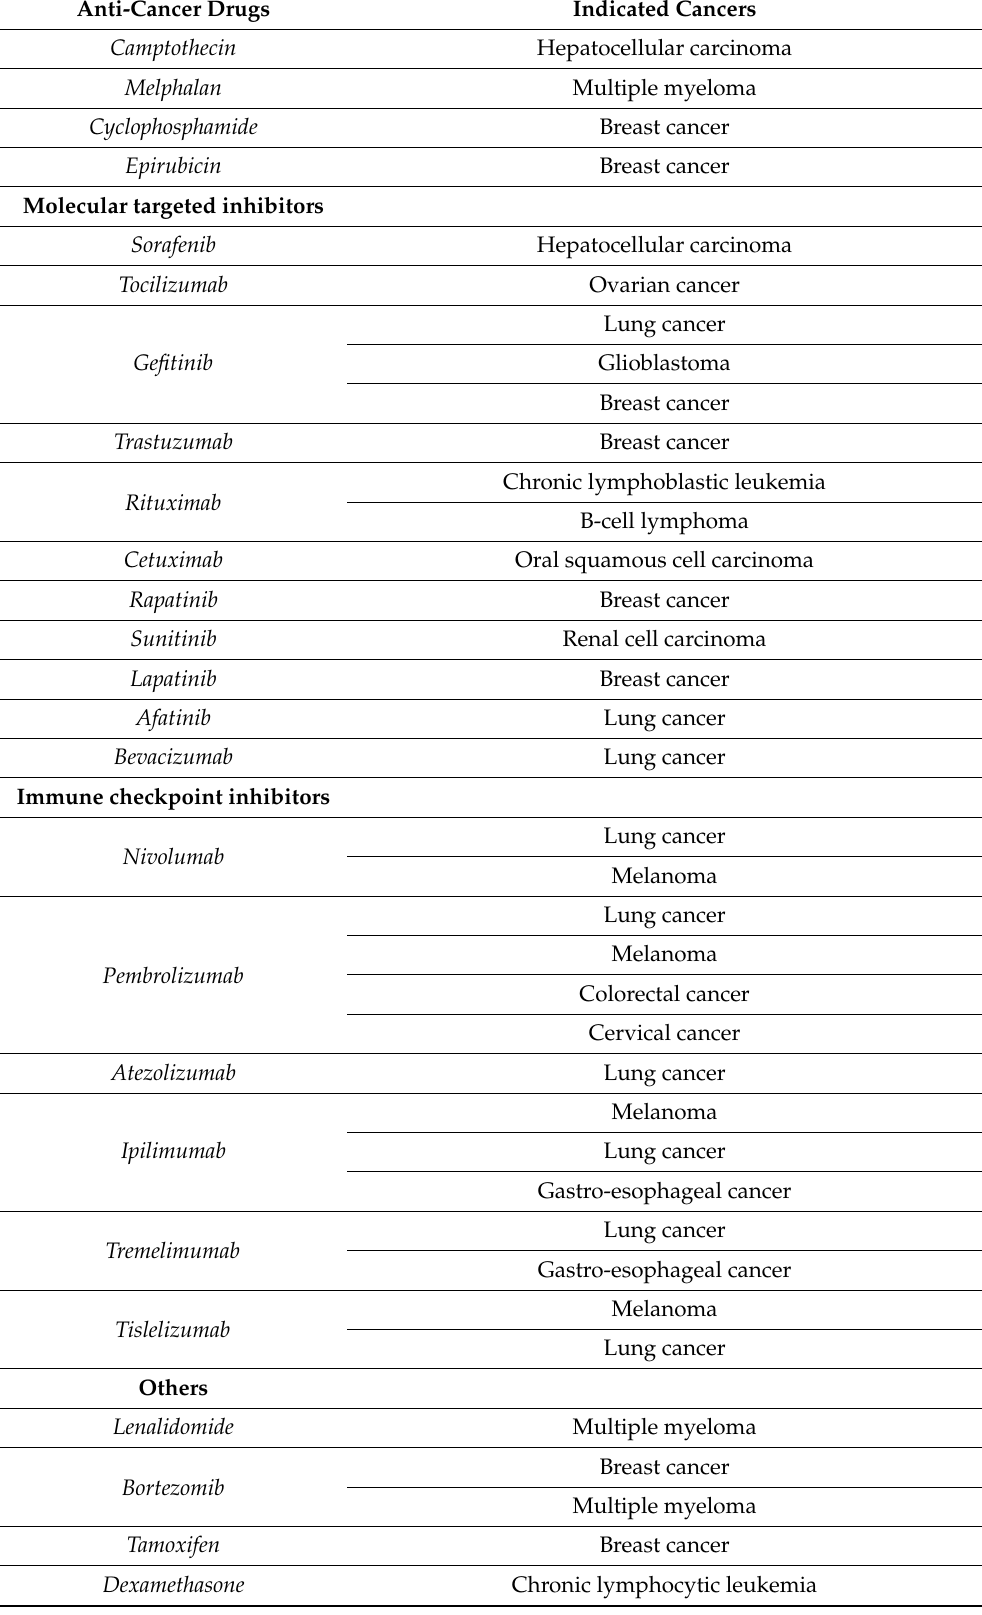
Table 1. Cont. Anti-Cancer Drugs Indicated Cancers